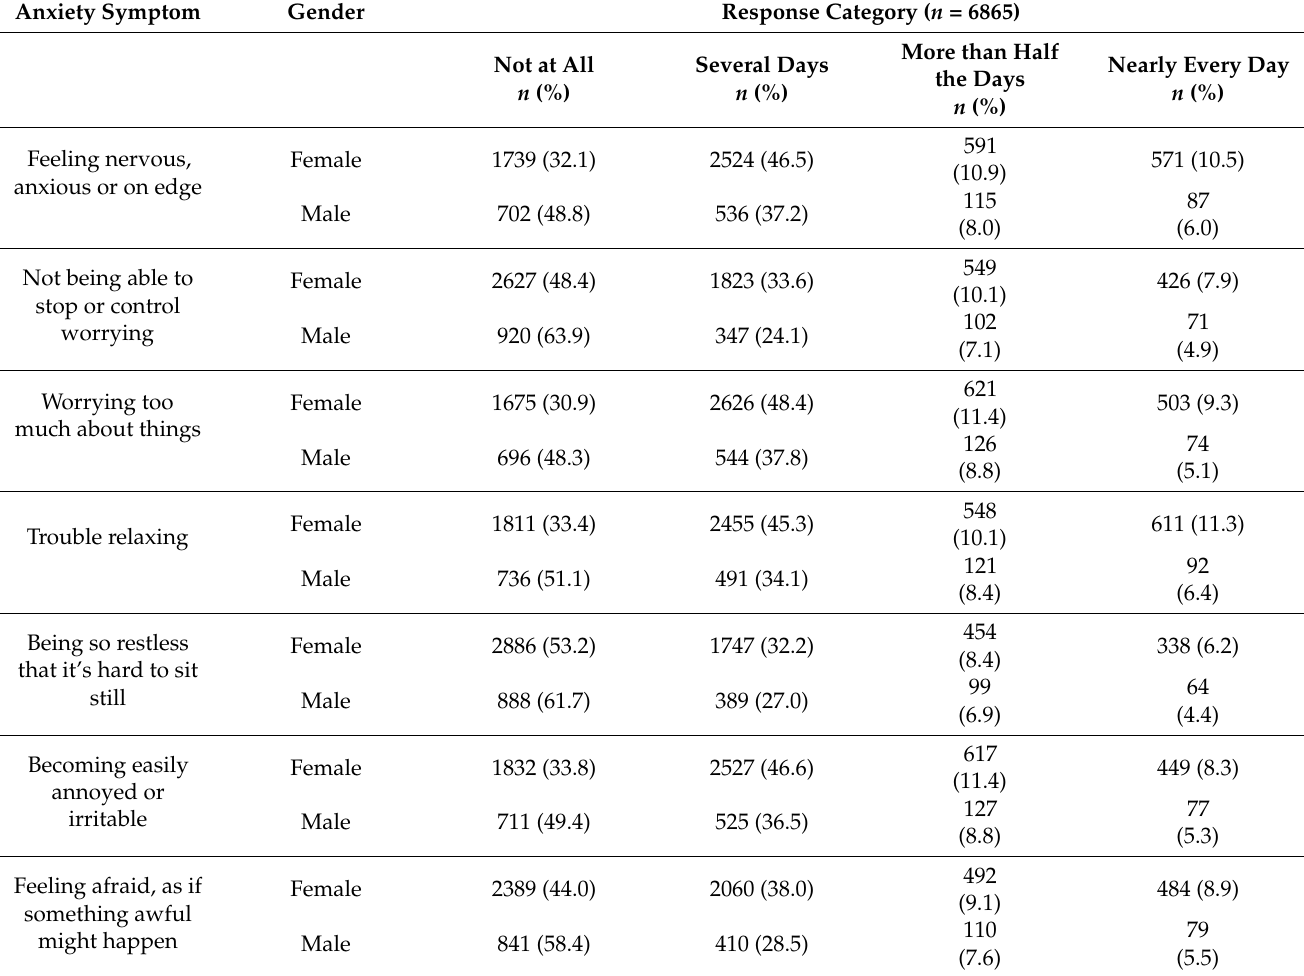
Table 4. Anxiety symptoms in men and women in the general population during COVID-19.